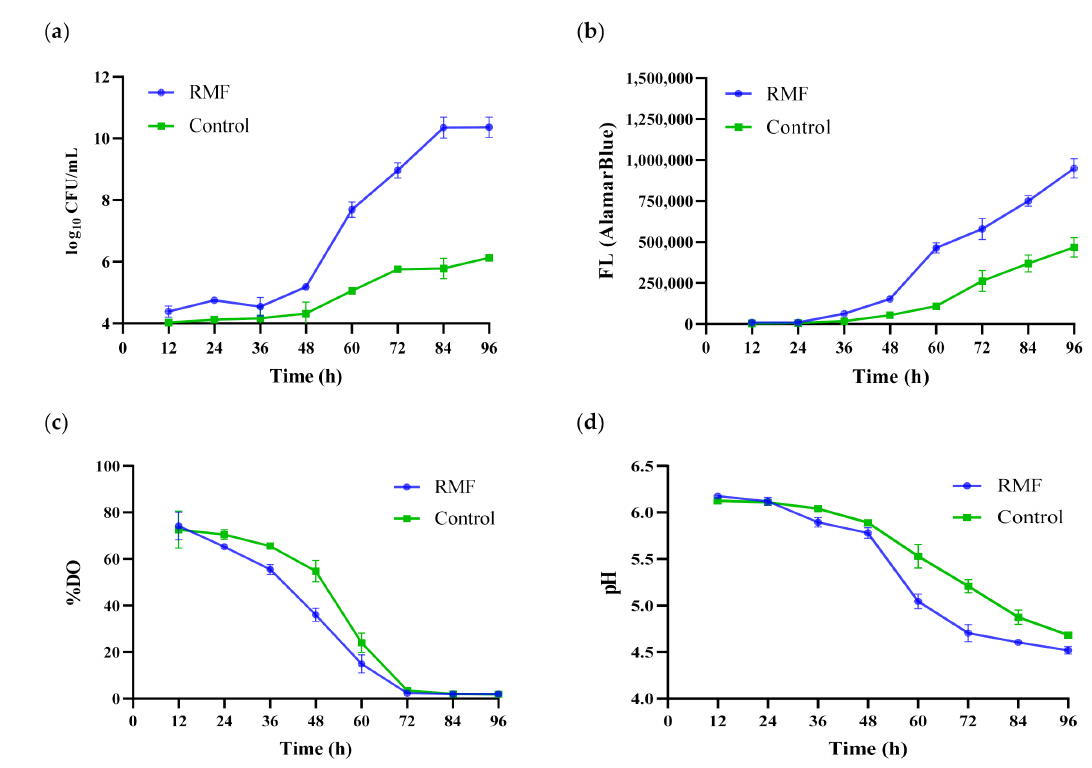
Figure 3. ( a ) The number of living cells; ( b ) metabolic activity of K. xylinus based on fluorescence of AlamarBlue reagent; ( c ) pH level; ( d ) %DO during first cycle of fermentation. Data are presented as a mean ± standard error of the mean (SEM).